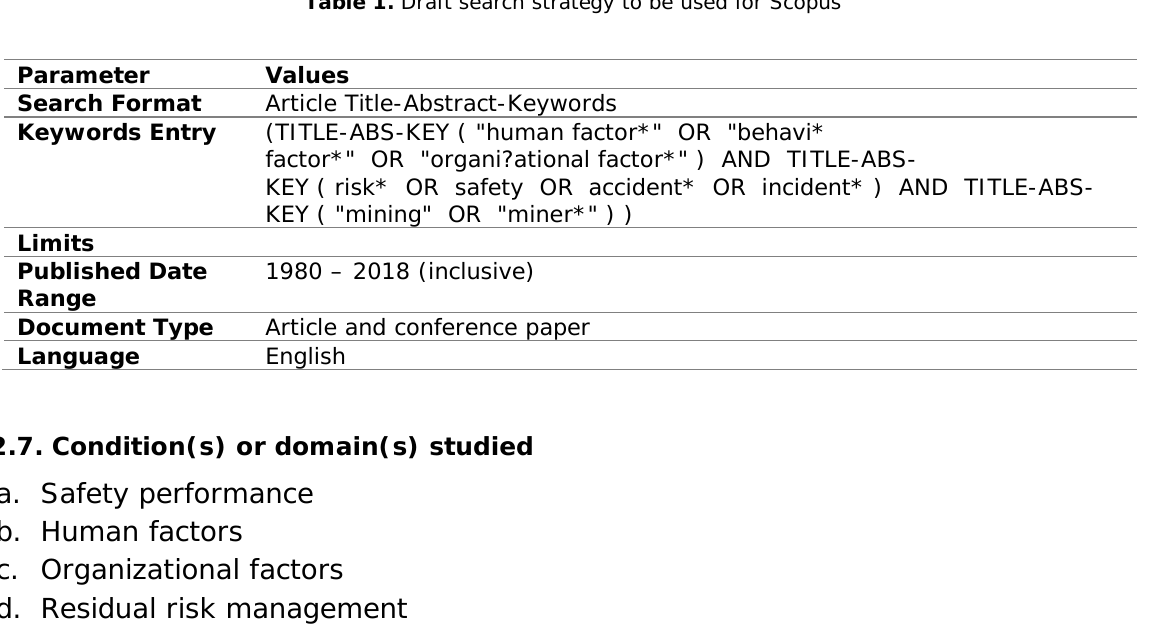
Table 1. Draft search strategy to be used for